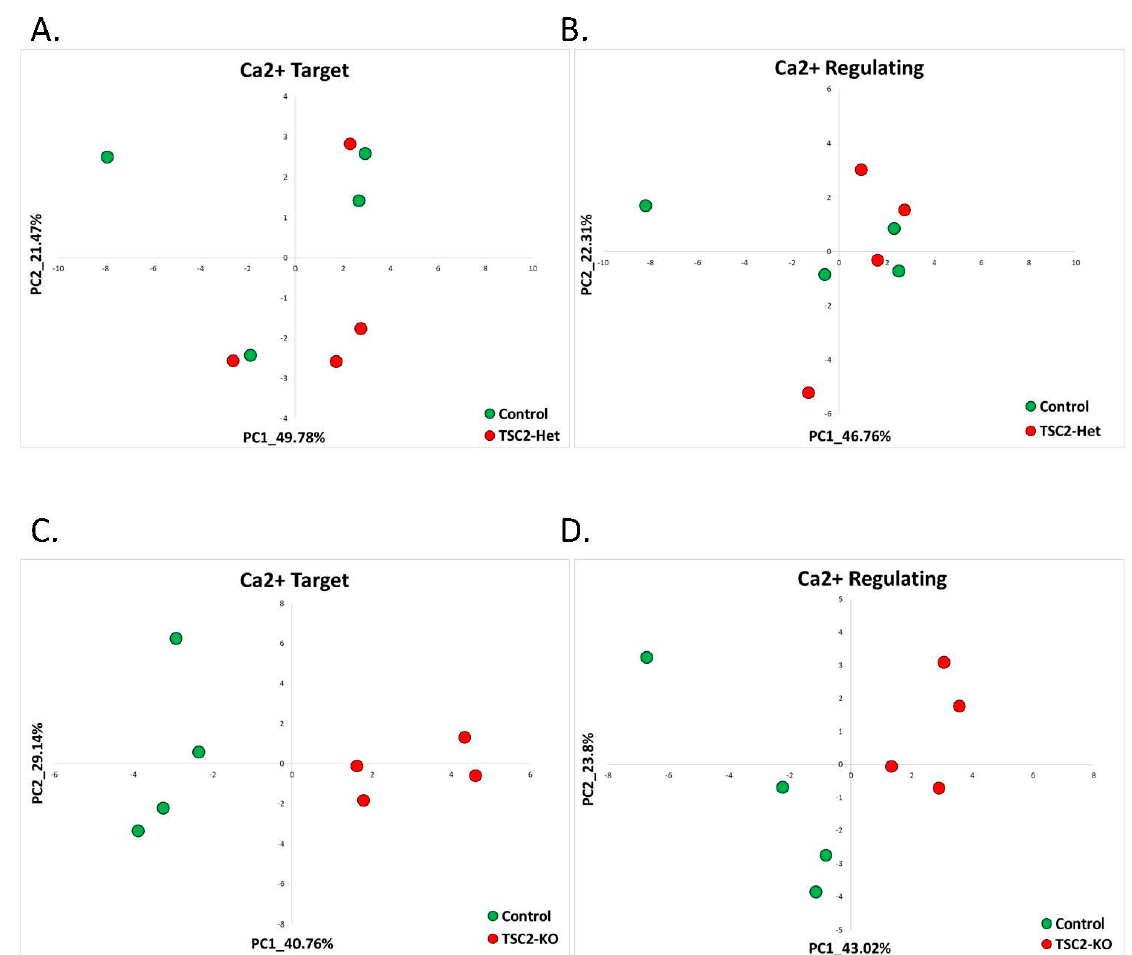
Figure 9. Tuberous sclerosis: calcium-target and calcium-regulating signatures. ( A ) PCA based on the expression of calcium-target signature genes in the TSC2 +/ − hESCs cell line (TCS2-Het) compared to the control hESCs cell line. The control samples are denoted in green, while the TCS2-Het samples are in red. ( B ) PCA based on the expression of calcium-regulating signature genes in the TSC2 +/ − hESCs cell line (TCS2-Het) compared to the control hESCs cell line. The control samples are denoted in green, while the TCS2-Het samples are in red. ( C ) PCA based on the expression of calcium-target signature genes in the TSC2 − / − hESCs cell line (TCS2-KO) compared to the control hESCs cell line. The control samples are denoted in green, while the TCS2-KO samples are in red. ( D ) PCA based on the expression of calcium-regulating signature genes in the TSC2 − / − hESCs cell line (TCS2-KO) compared to the control hESCs cell line. The control samples are denoted in green, while the TCS2-KO samples are in red.